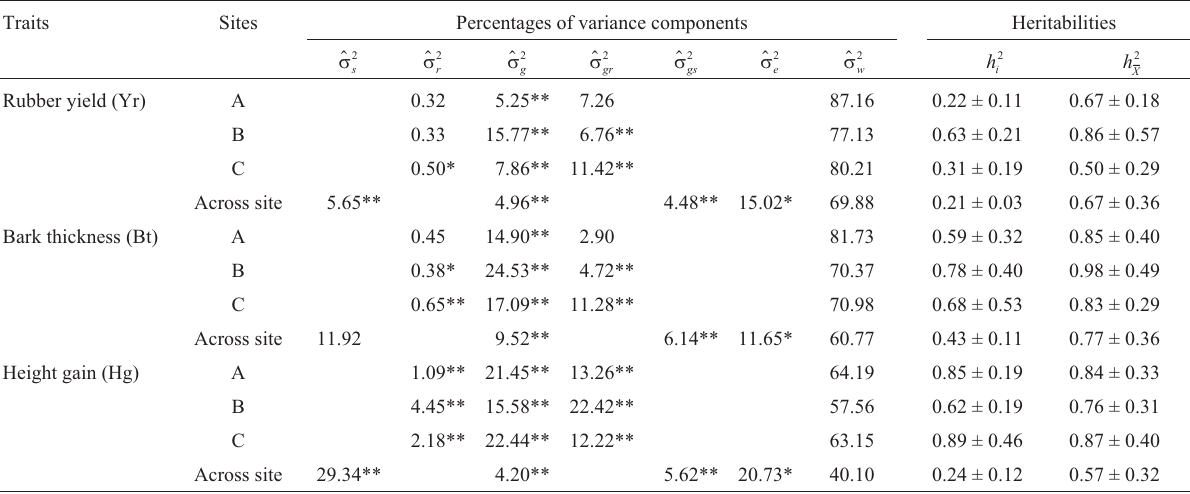
Table 4 - Site-related percentages of variance components and heritabilities for rubber yield, bark thickness and height gain in 22 open-pollinated Hevea progenies growing at three sites (Votuporanga (A), Pindorama (B) and Jaú (C)) in the Brazilian state of São Paulo. Traits Sites Percentages of variance components Rubber yield (Yr)